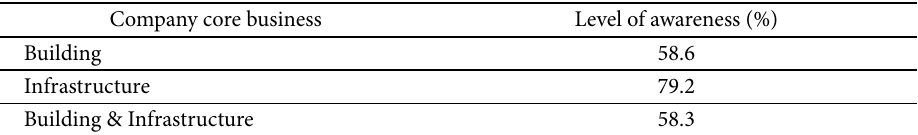
table 3. level of awareness on environmental sustainability of construction companies according com- pany core business